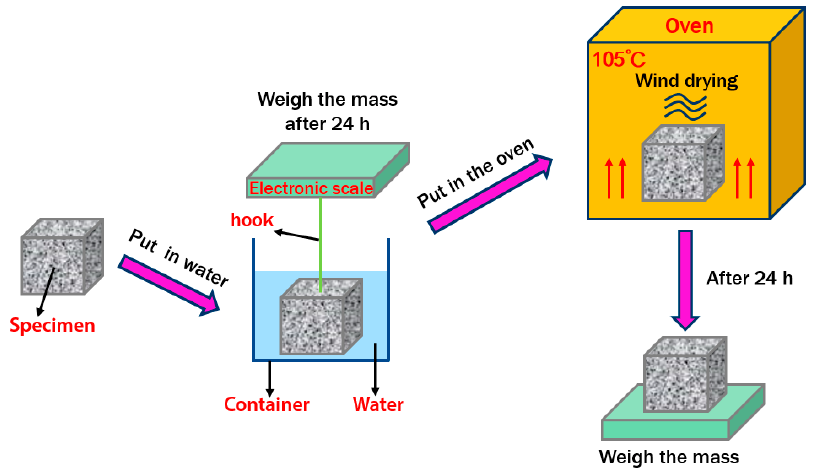
Figure 6. Flow chart of porosity test for porous